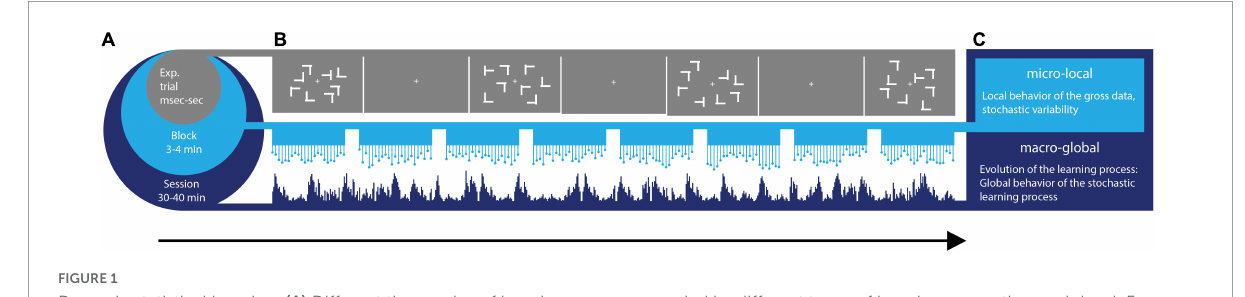
FIGURE1 Dynamic statistical learning. (A) Different time scales of learning are accompanied by different types of learning supporting each level. From a level at sub-second time scales, to the scale of 40 min, different levels of granularity in the data afford different levels of precision to describe learning phenomena. Averaging out fluctuations in the system’s responses may eliminate gross data containing important information on learning mechanisms. These may be varying from trial to trial and from block to block at each level. (B) Visual search task: the target was a letter T rotated either left or right that appeared among rotated Ls (distractors). Across trials, the spatial configurations of target and distractors (i.e., layouts) could repeat (correlated group), be generated randomly (random group) or repeat on half of the trials (mixed group). (C) Micro-Local vs. Macro-Global signatures of variability are extracted from fluctuations in EEG signals recorded while participants searched for the target and pressed the corresponding response key as fast as